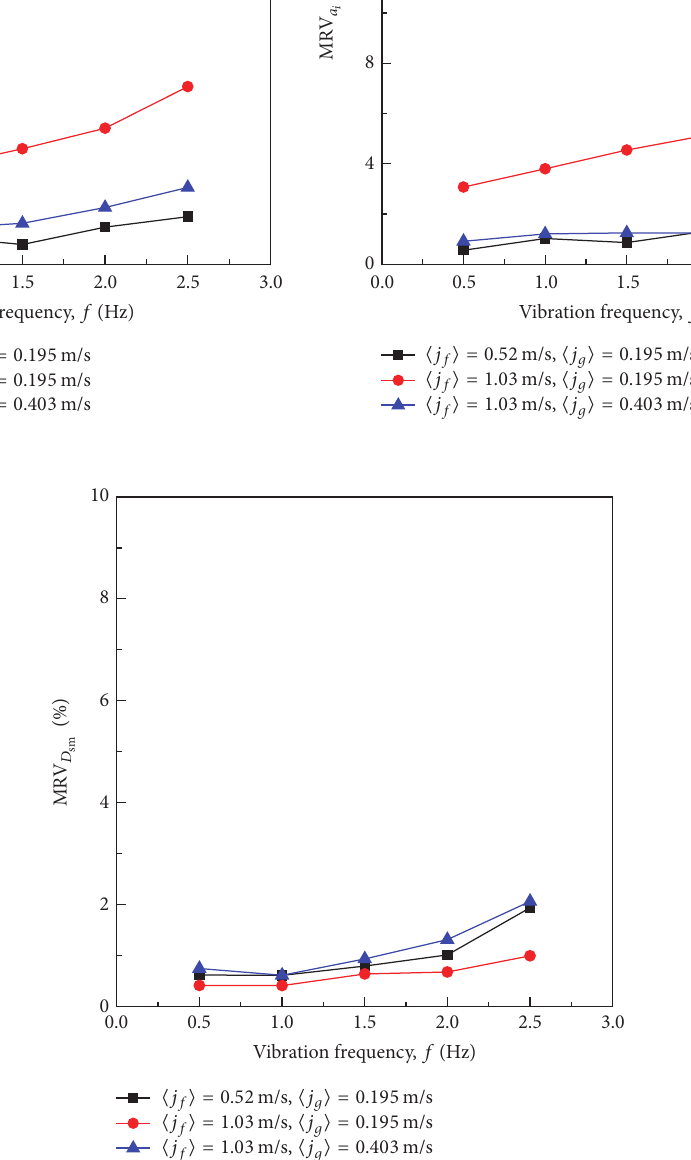
Figure 5: Vibration frequency effect on MRV of time-averaged flow parameters.